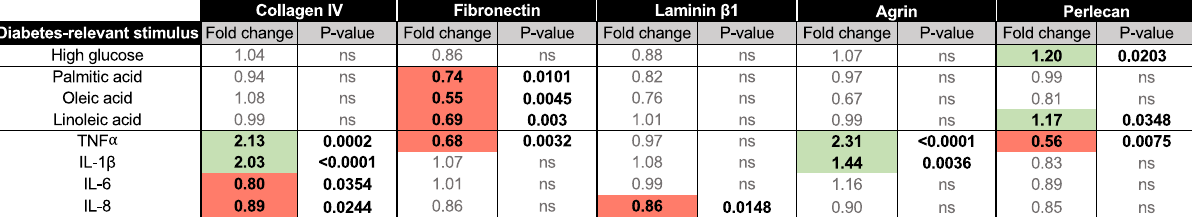
Table 2. Diabetes-relevant stimuli cause significant effects in ECM expression by hRMEC. All statistical comparisons used t-tests between the DRS-treated group and its respective vehicle, except for the case where normal glucose, l-glucose (osmotic control), and high glucose were compared. In that case ANOVA with Tukey post-hoc was used. For simplicity, only l-glucose vs high glucose is reported here. Expression data are reported as fold induction over vehicle. Red cells highlight statistically significant decreases in expression; green cells highlight statistically significant increases in